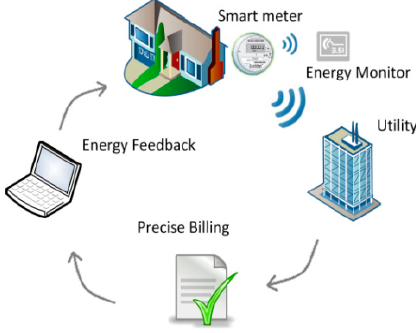
Figure 3. Example of the usage of a smart meter and an in ‐ home display.